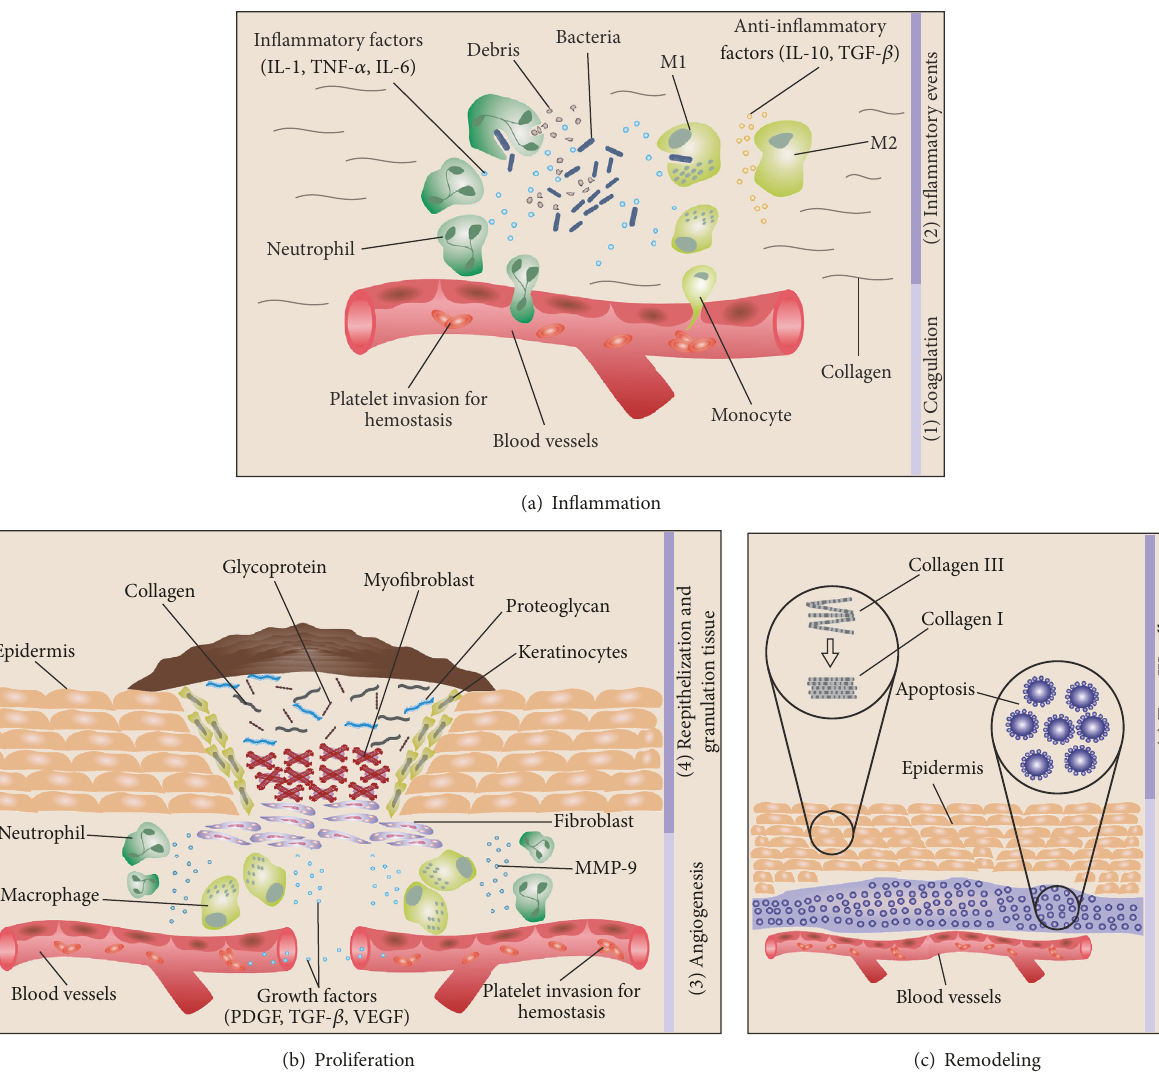
Figure 1: Progression and overlap of the phases involved in the physiological wound healing process: (a) inflammation begins with (1) coagulation, platelet aggregation, and fibrin clot formation; (2) then inflammatory events occur through neutrophils and macrophages infiltration and phagocytosis of debris, apoptotic cells, and pathogens; anti-inflammatory events occur through inhibition of destructive inflammatory process and proliferation promotion. (b) In the proliferation occurs (3) angiogenesis; (4) reepithelization (epithelial cell mitosis and fibroblasts transformation into myofibroblasts), and granulation tissue formation (EMC composed of collagen, glycoprotein, proteoglycan, fibroblasts, and keratinocytes, under modulation of MMP-9). (c) Remodeling is marked by the (5) EMC reorganization: cells apoptosis and angiogenesis regression; and (6) type III collagen replaced by type